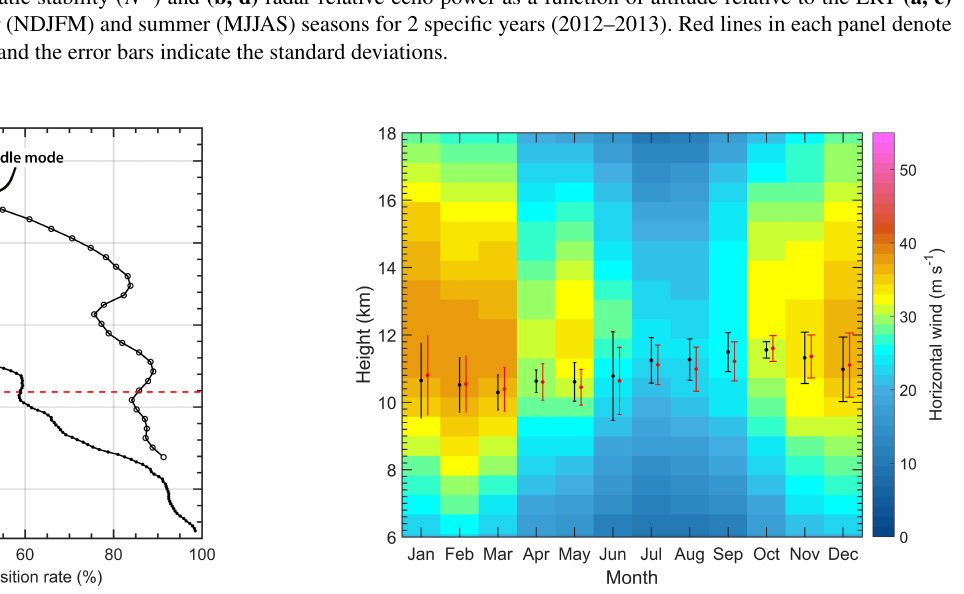
Figure 8. Vertical height profiles of the averaged effective radar wind data-acquisition rate in low mode and middle mode during November 2011–May 2017. The red dashed line indicates the mean RT height.